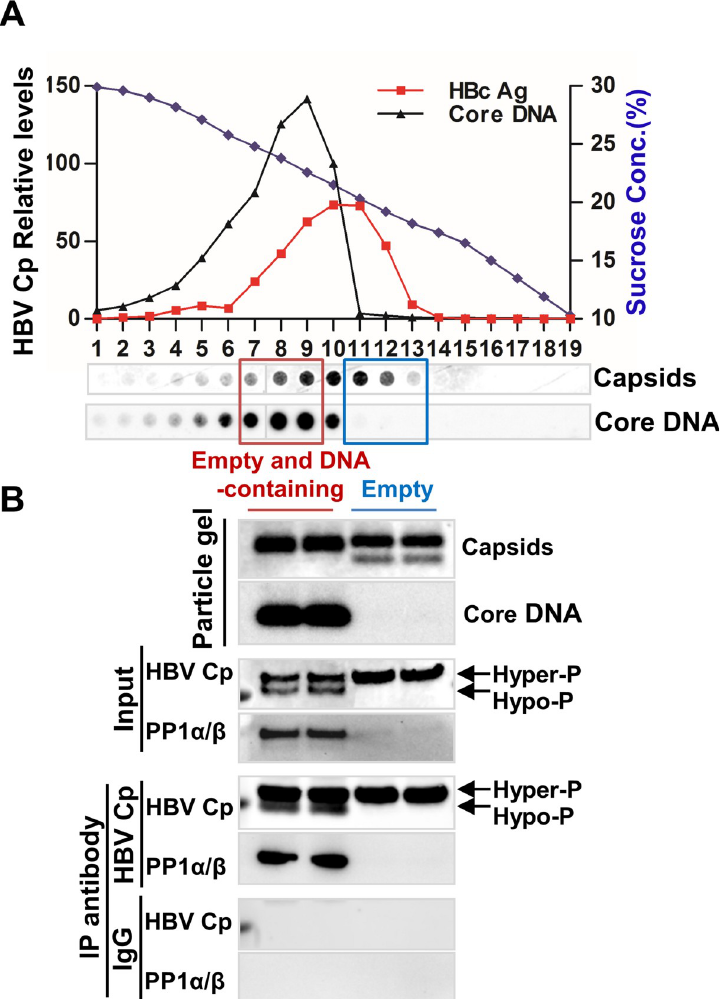
Fig 6. PP1 α / β are encapsidated into DNA-containing nucleocapsids, but not empty capsids in HepAD38 cell. ( A ) HepAD38 cells were cultured in tet-free medium for 6 days. Intracellular capsids were separated by 15–30% linear sucrose gradient centrifugation with a Beckman SW28 rotor at 27,000 rpm for 4 h. Nineteen equal-volume fractions were collected from the top of the tube. HBV core protein/capsids in each fraction were detected by a dot immunoblot assay and core-associated HBV DNA were detected by hybridization with an α - 32 P-UTP labeled full-length positive strand RNA as a probe. Capsids and core DNA were quantified with Gelpro32 software and plotted. ( B ) Samples of fractions 7 to 9 and 11 to 13 were pooled and concentrated. The capsids and associated viral DNA were determined by particle gel assay. IP were performed with an antibody against HBV Cp or control IgG. HBV Cp, PP1 α and β in input cell samples and immunocomplexes of IP were detected by Western blot assays with the corresponding antibodies. from HepAD38 cell lysates. Similar to that observed in mouse hepatocytes, the sucrose gradi- ent ultracentrifugation can partially separate empty capsids (Fractions 11 to 13) and viral DNA-containing nucleocapsids (Fractions 7 to 9) (Fig 6A). While the capsids pooled from the three empty capsid fractions were primarily empty capsids, the capsids pooled from the three DNA-containing capsid fractions contained also significant amounts of empty capsids. In agreement with our previous observation [25], while the empty capsids migrated as two species with distinct electrophoresis mobility, capsids in DNA-containing capsid fractions migrate as single species (Fig 6B, top panel). Western blot analysis indicated that while hyperphosphory- lated Cp existed in both fractions, hypophosphorylated Cp as well as PP1 α and β were only